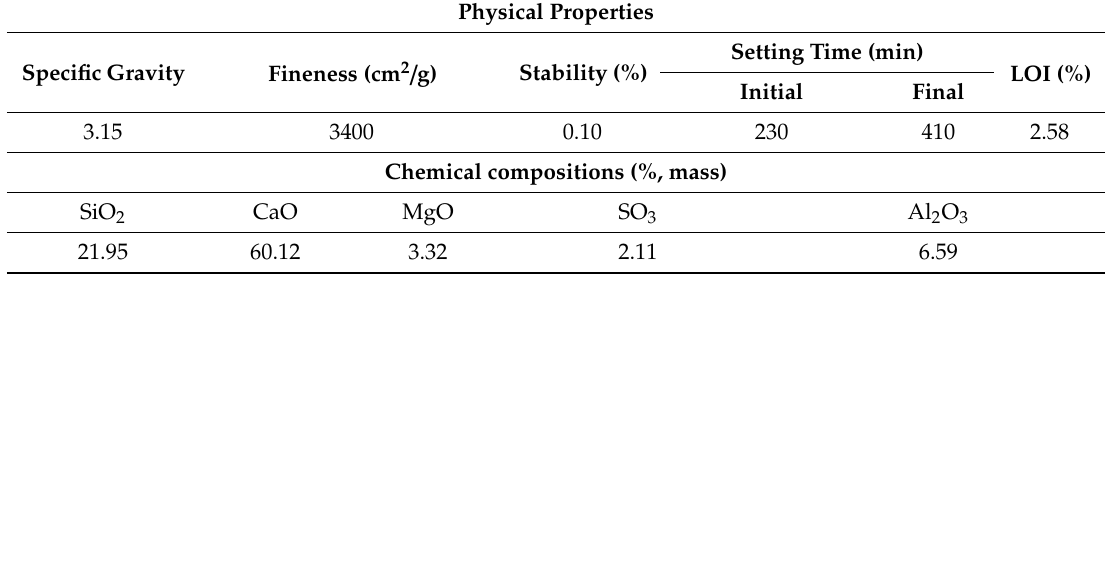
Table 1. Physical and chemical properties of the used